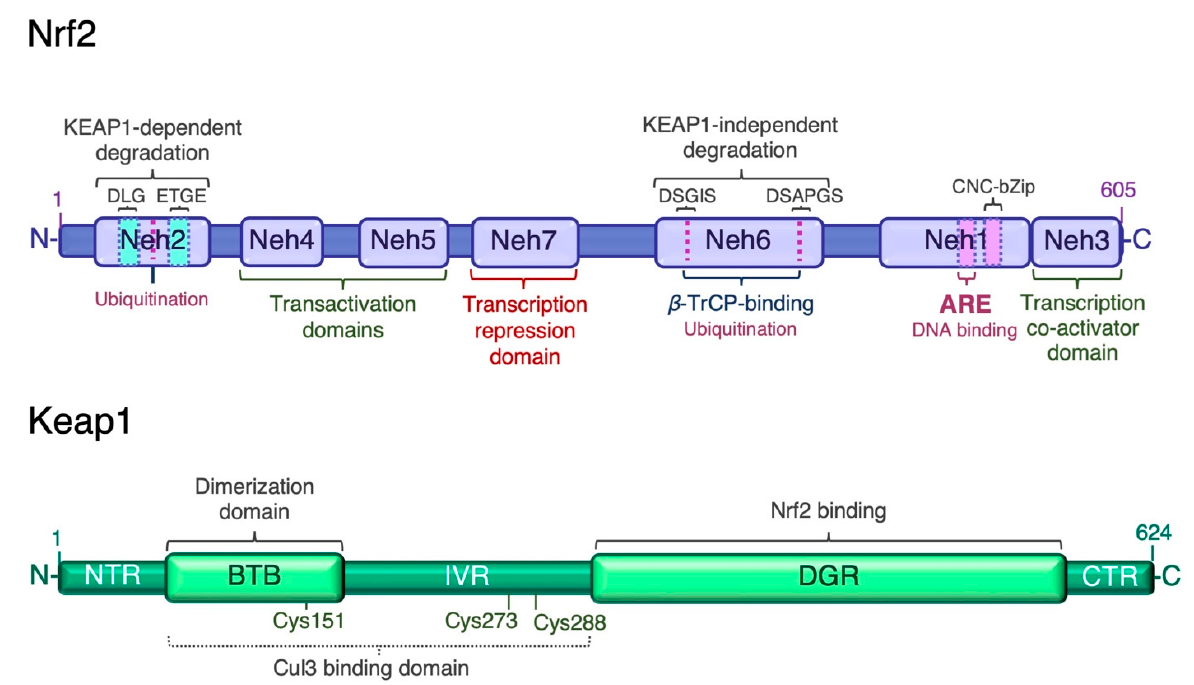
Figure 1. Structure of human Nrf2 and Keap1. The high-affinity ETGE and low-affinity DLG motifs in the Neh2 domain of Nrf2 are bound by the Kelch domain of Keap1 for Nrf2 ubiquitination and degradation. ARE, antioxidant response element; BTB, broad-complex, tramtrack and bric-à-brac domain; CTR, C-terminal region; DGR or Kelch, double glycine repeat domain; IVR, intervening region; Neh, Nrf2-erythroid-derived CNC homology (ECH) domain; NTR, N-terminal region.